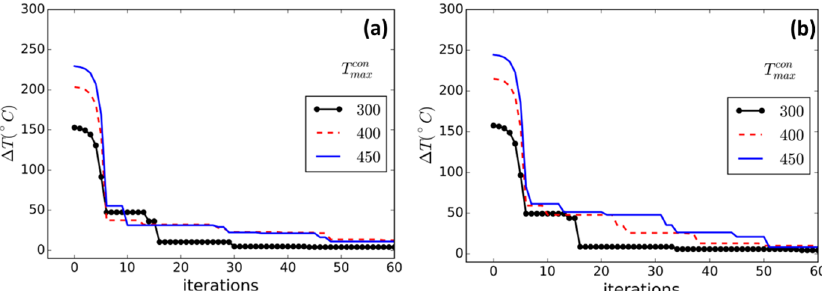
Fig. 7. Temperature difference convergence for the tested pro fi les (a) pro fi le #1 and (b) pro fi le #2.